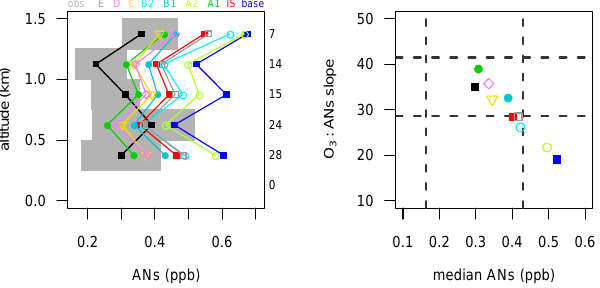
Fig. 7. Modeled and observed vertical profile of P ANs median concentrations (left) and the slope of the O 3 and P ANs relationship (right). Data are selected with the same criteria as those in Fig. 4 (daytime observations within 2 km of the surface and with observed isoprene > 500ppt). Left: The grey boxes show the interquartile ranges of observations. Numbers on the right side of the plot indi- cate data points in each vertical bin. Right: Uncertainty range of the observations is indicated by horizontal dashed lines (standard error of the fitted slope) and vertical dashed lines (interquartile values of P ANs). (black square: observation; blue square: base; red square: IS; solid green circle: A1; open green circle: A2; solid blue circle: B1; open blue circle: B2; orange triangle: C; purple diamond: D; grey square: